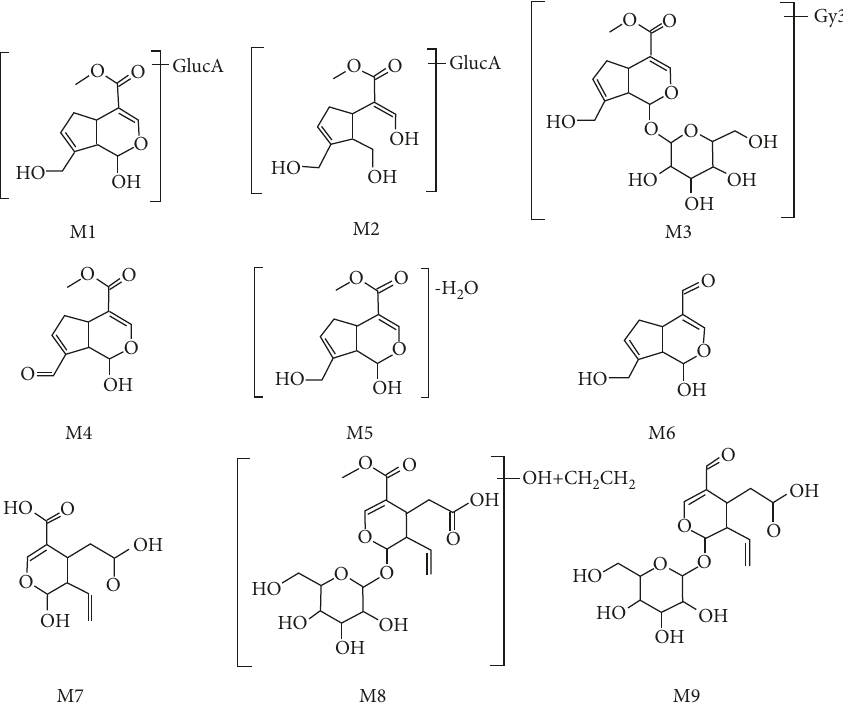
Figure 7: The structures of metabolites in rat plasma. Table 8: The regression equations and linear range of the metabolites. Analyte Regression equations Correlation coefficient Linear